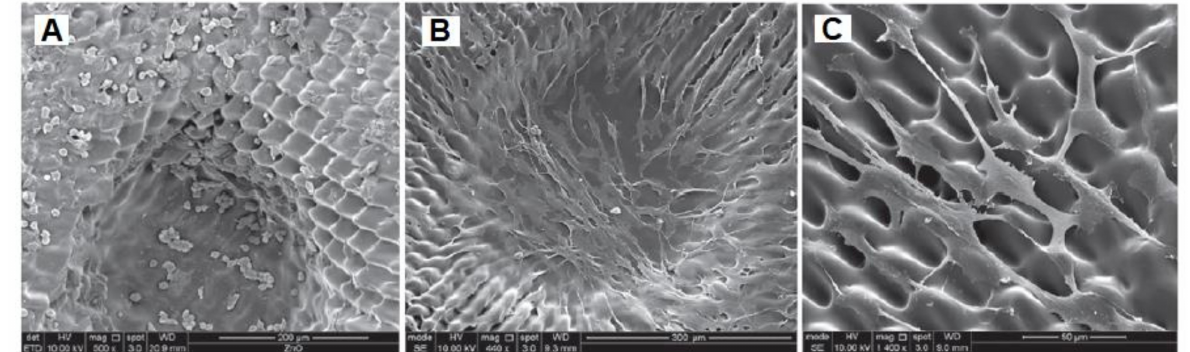
Figure 11. ( A ) Shows a washed sample of the SEM images of cells in the short term. ( B ) Shows a washed sample of the SEM images of cells in the long term. ( C ) Shows an SEM high-magnification image of well-attached RLF on PEGDA surface